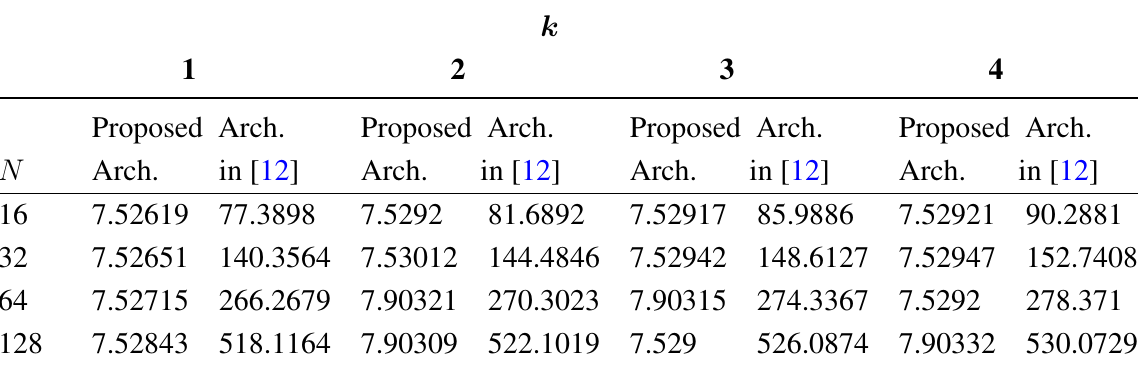
Table 5. The CPU time of the proposed hardware architecture and the hardware architecture proposed in [12] for different k and N values (in ms ).